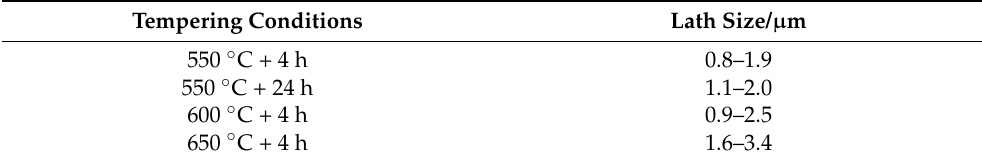
Figure 4. The average ( a ) length ( b ) width and ( c ) number density variations for carbides in Dievar steel in different tempering conditions (SEM observations).